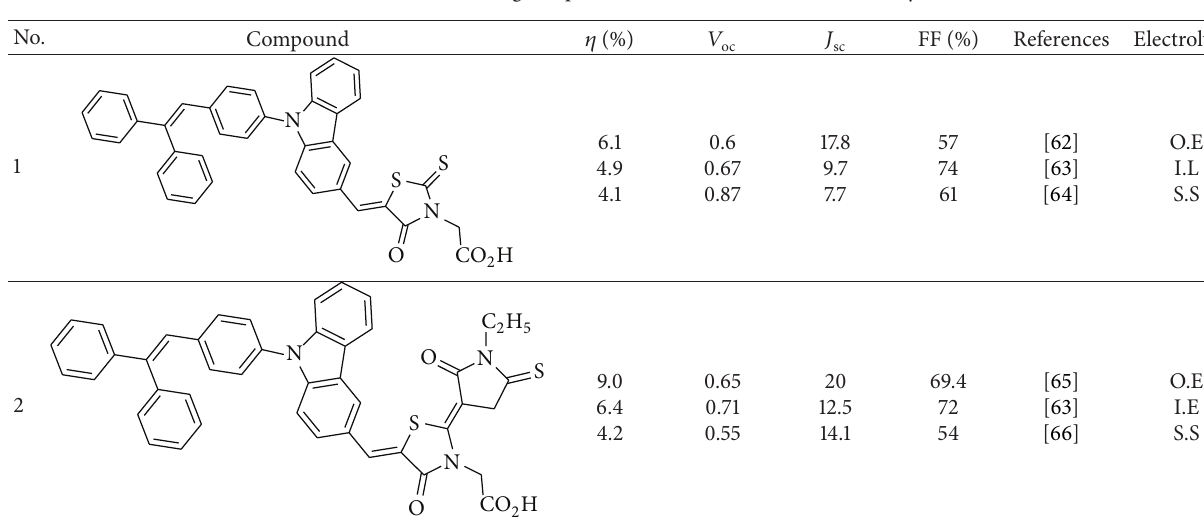
Table 2: Metal free organic photosensitizers with different electrolytes.